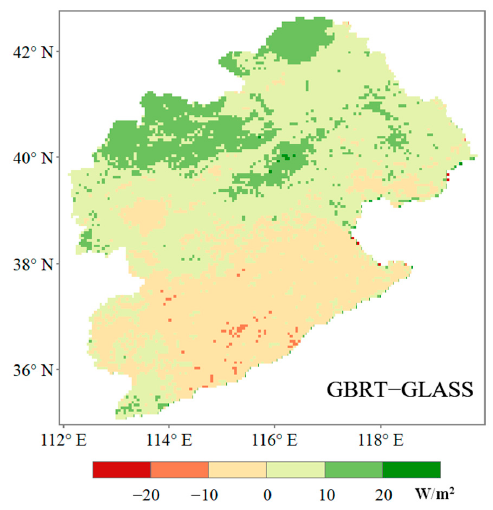
Figure 11. Spatial differences in the average annual terrestrial LE (2016–2018) between GLASS LE product and LE product estimated using GBRT algorithms.